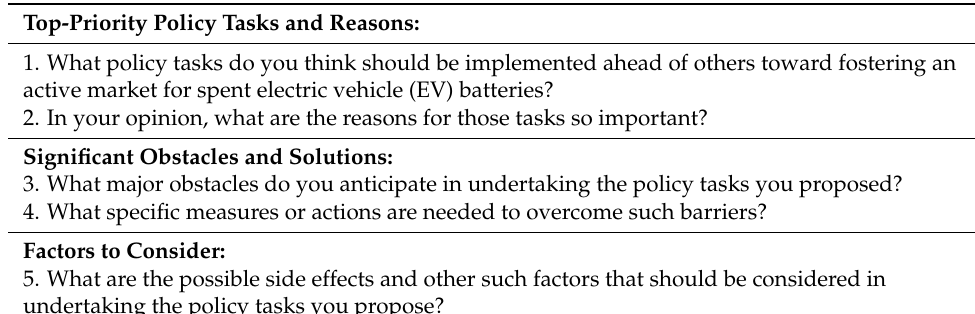
Table 1. Top-priority policy task identification (TPTI) questionnaire.